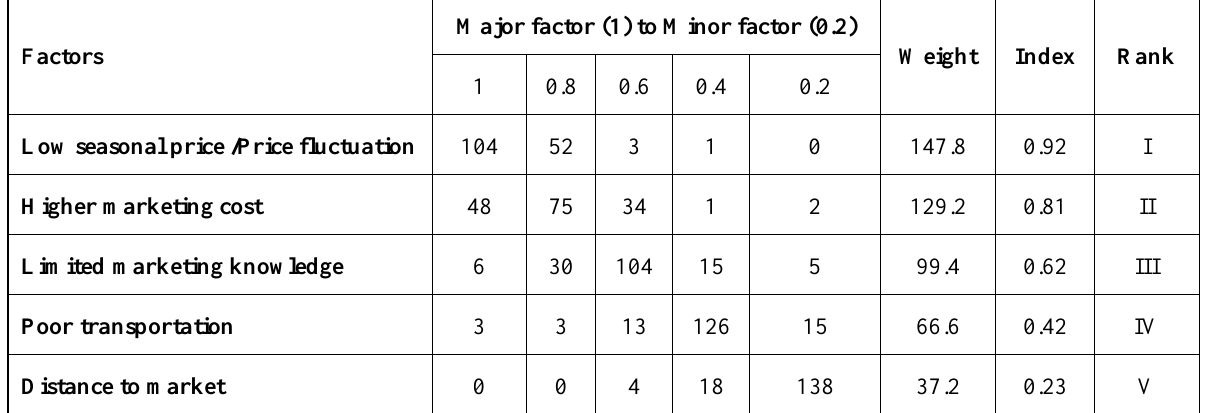
Table 14. Various marketing problems of LC farmers in the study area Major factor (1) to Minor factor (0.2) Factors